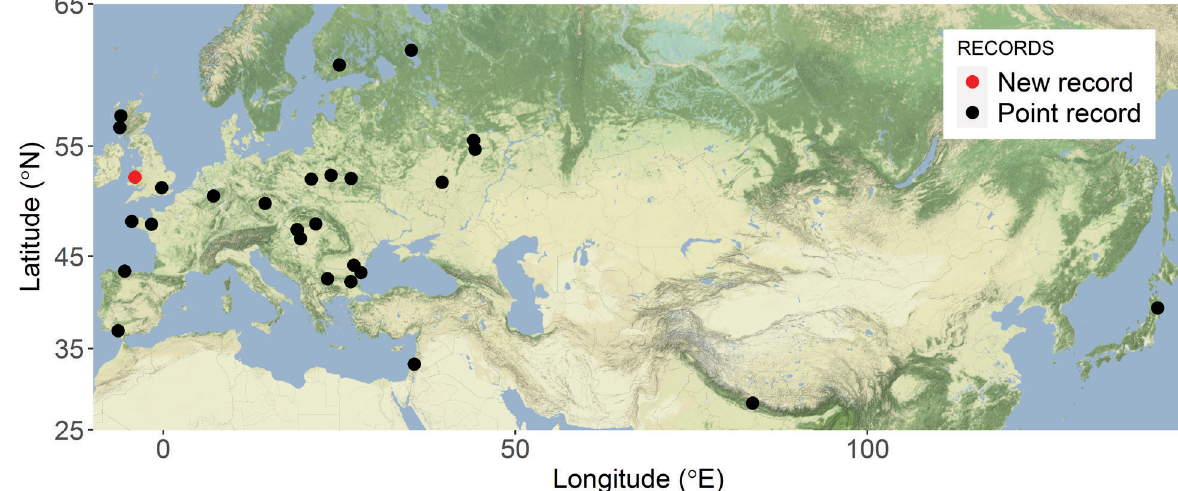
Figure 1. The geographical distribution of Carolinensis minutus in the Palearctic. Exact or approximate point records based on information derived from references cited in the main text and from Bugmyrin et al. (2015), Tenora et al. (1980), and Torres et al. (1983). The new record is the first in mainland Britain not associated with the release of captive-bred